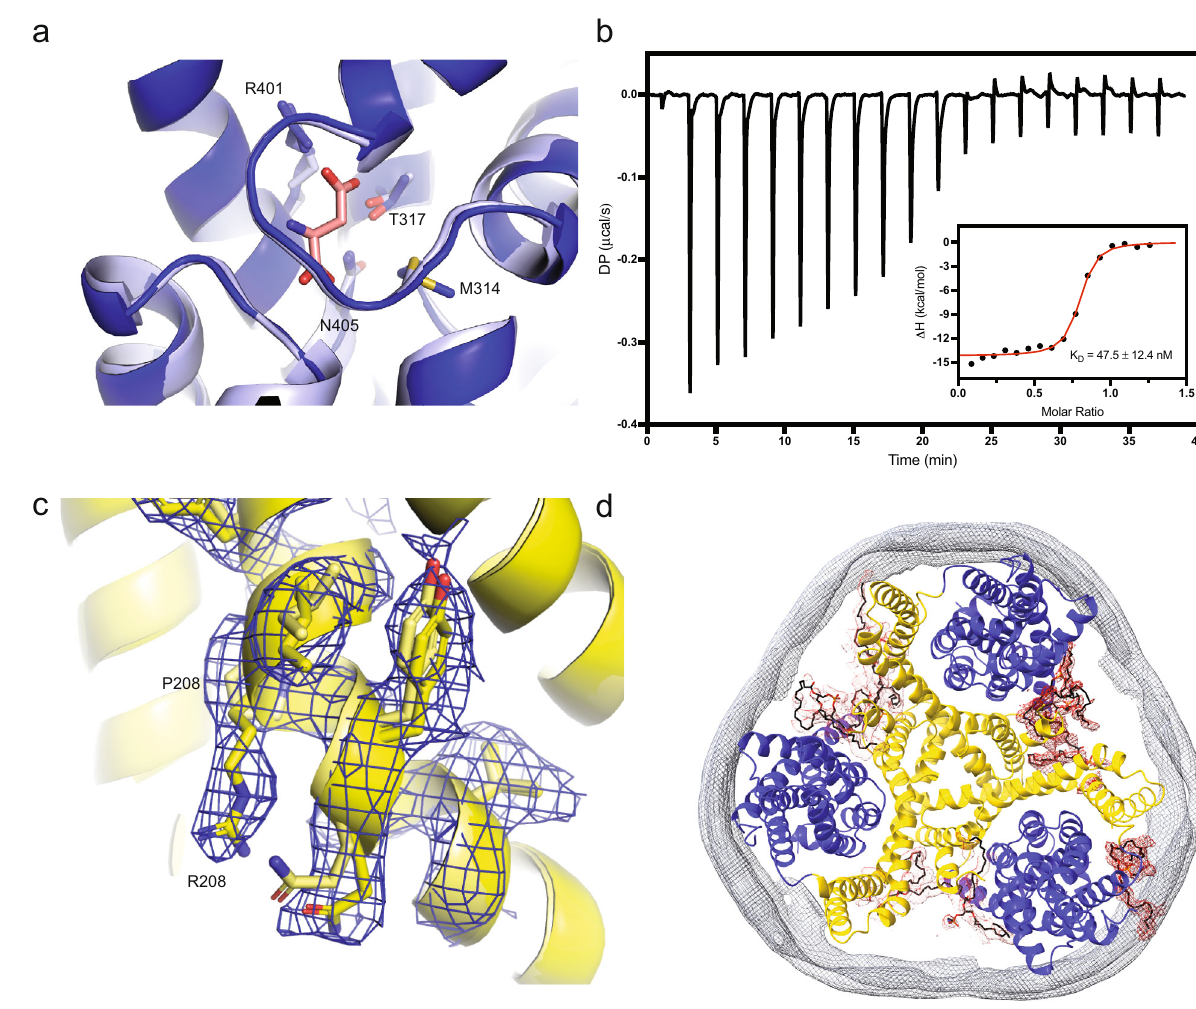
experiments). Cryo-EM density ( c ) for the side chain of arginine 208 and neigh- bouringresidues(viewfromthemembraneplane,extracellularsidebelow)and( d ) forthebeltproteinofananodisc(grey)andputativelipids(red).Mapsareshownat 4 σ . Source data are provided as a Source data fi